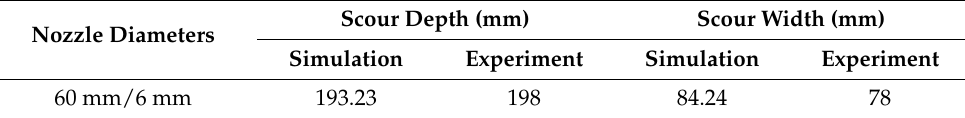
Table 4. Comparison between numerical simulation results and experimental results.